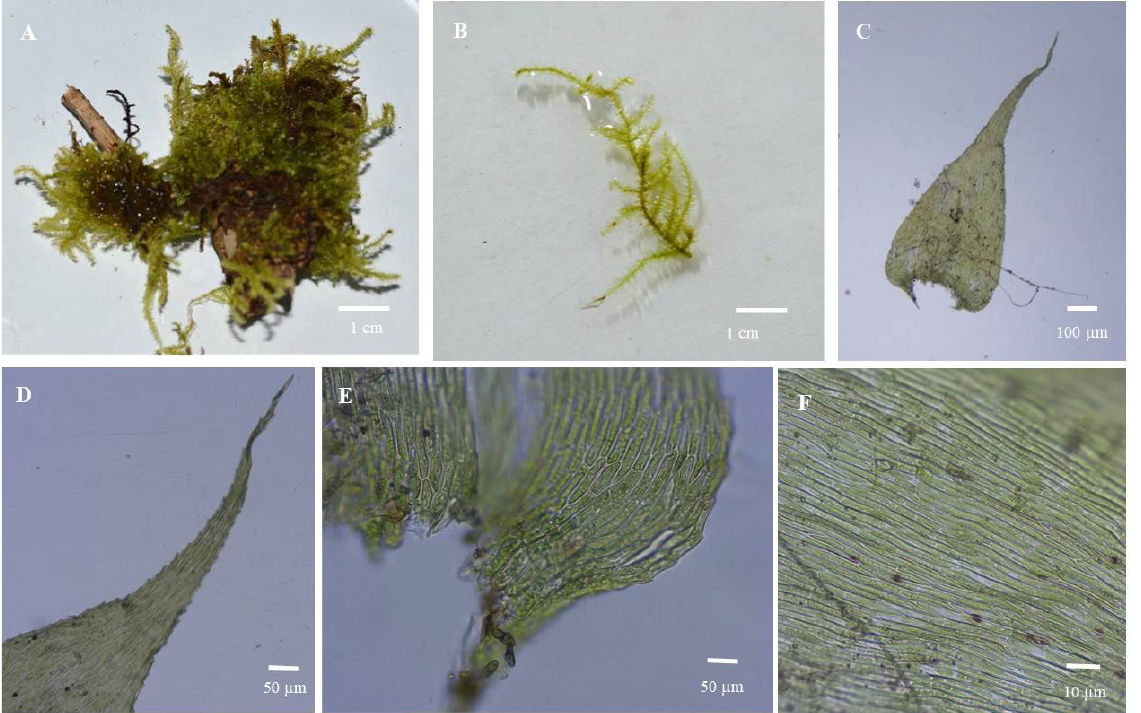
Figure 2: Ctenidium pinnatum A) Habit of the plant B) A branch showing pinnate branching pattern C) Stem leaf D) Acuminate leaf apex E) Leaf base F) Leaf lamina